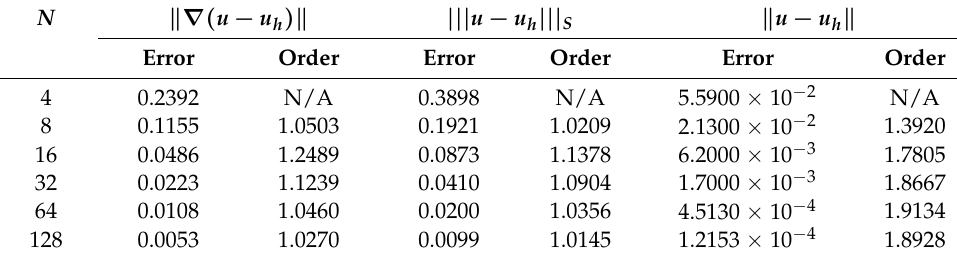
Figure 2. B.C. I Figure 3. Figure 4. B.C. III. Table 2. Experiment results for the exact solution u = x 2 + y 2 with B.C.